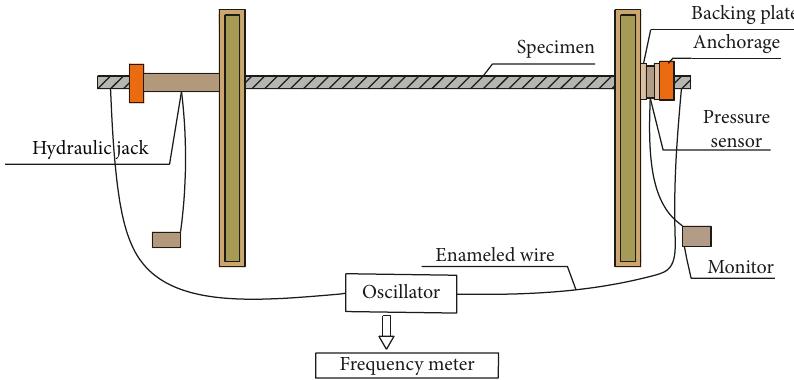
Figure 9: 6m/10m/14 m experimental device of steel strands. Table 1: Table of experimental